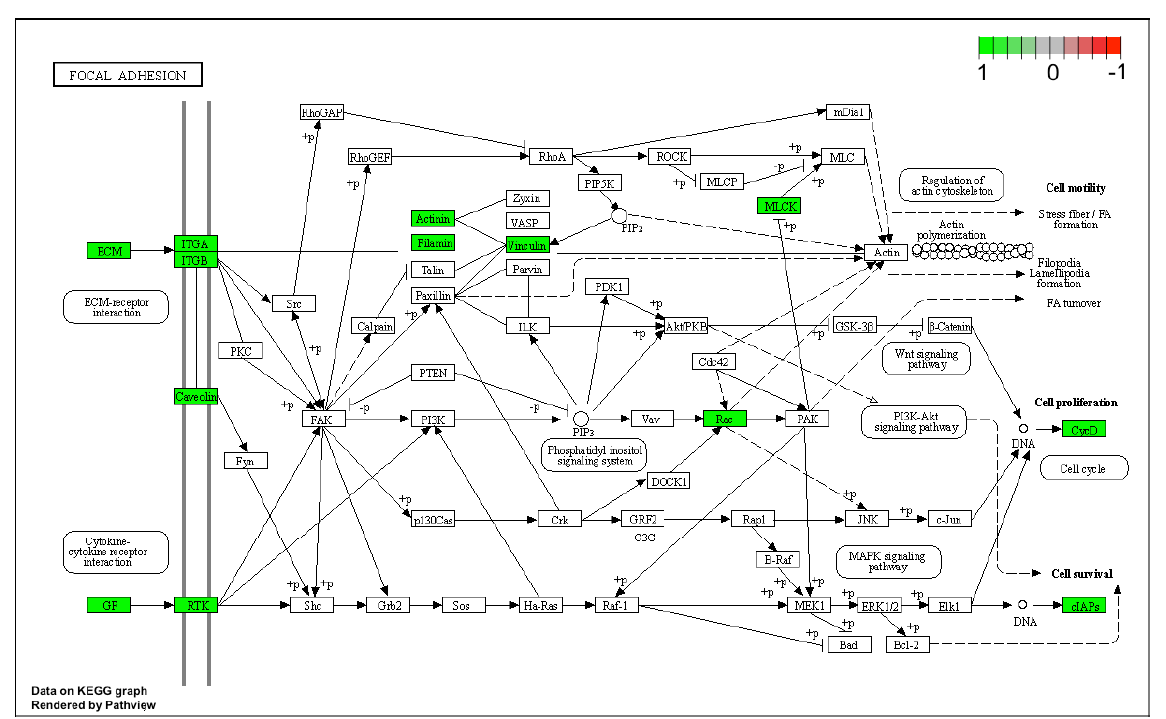
Figure 8 . Pathway graph of the focal adhesion signaling pathway based on the KEGG database. The green color indicates parts of the pathway that are upregulated after 7 days of human cumulus-oophorus cell culture in vitro.